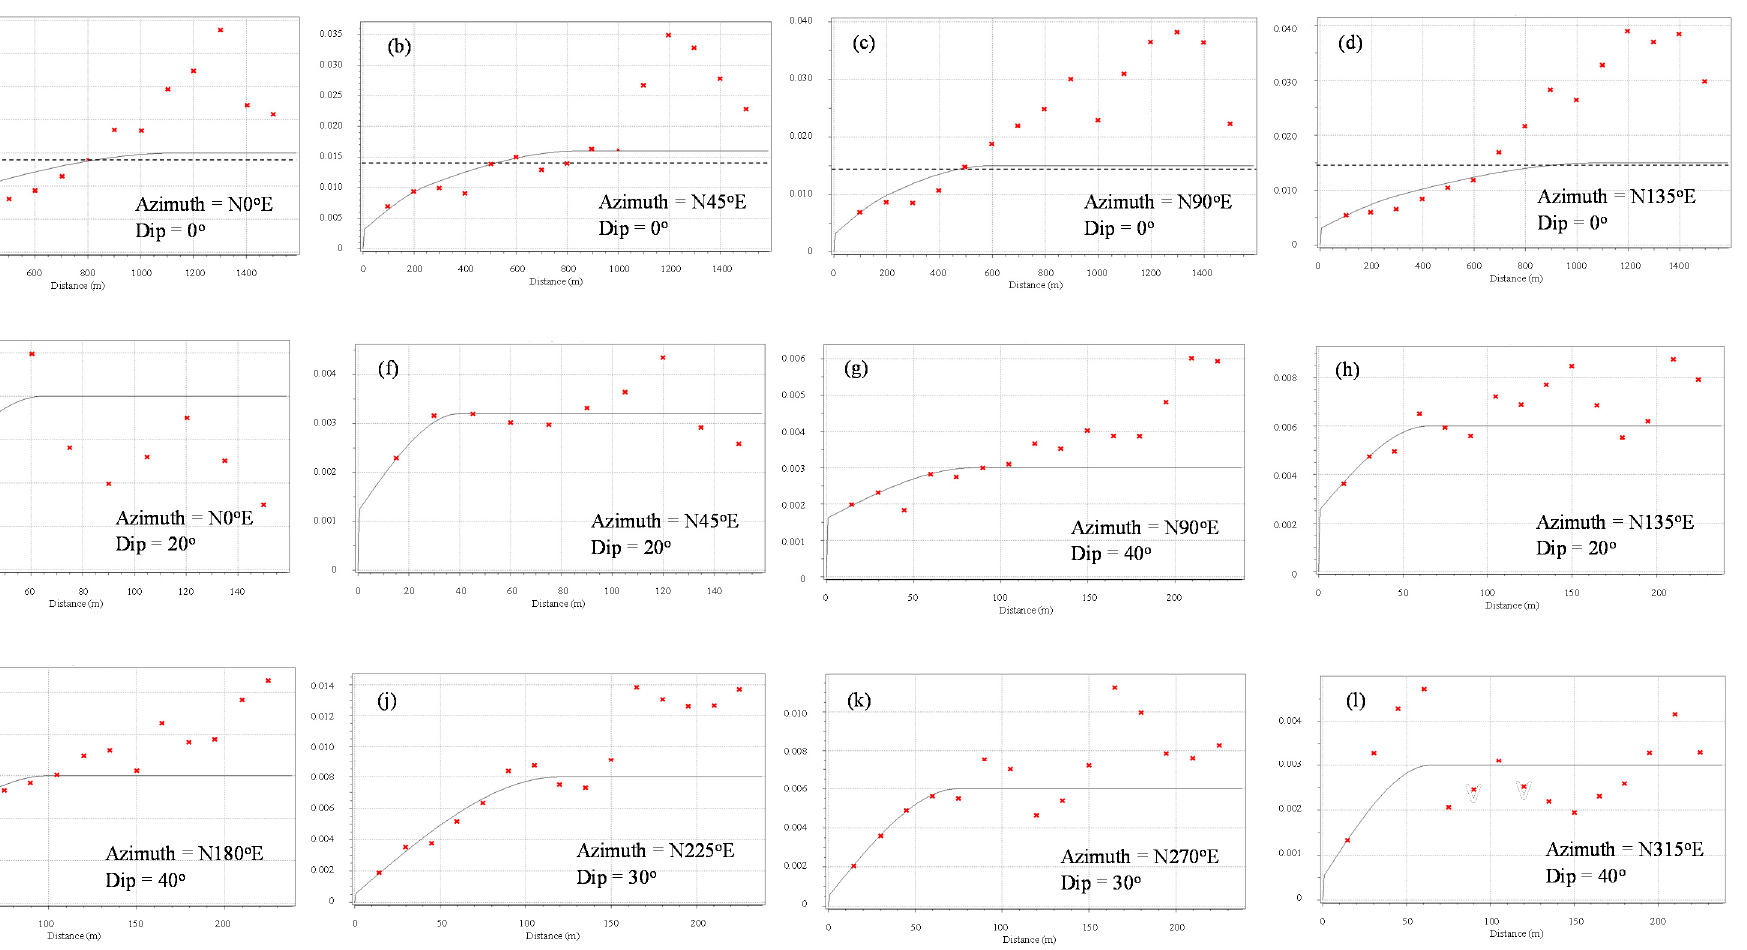
Figure 3. Experimental variograms and their fitting models for four horizontal directions ( a – d ) and eight inclined directions ( e – l ). The horizontal dash line in Figure 3 ( a – d ) is the variance of Zn grade (i.e., 0.014%). Red cross point is experimental variogram while the black line is the fitting model.